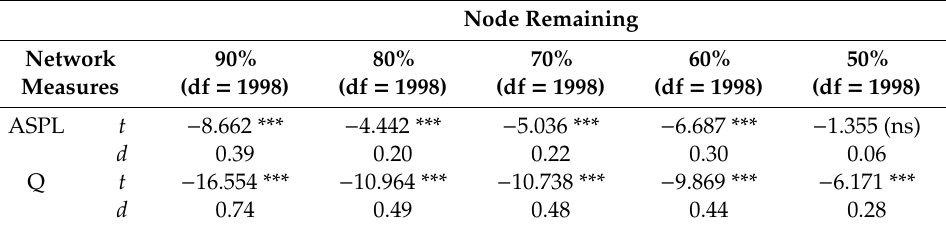
Table 6. Partial network bootstrapped results for the Gf